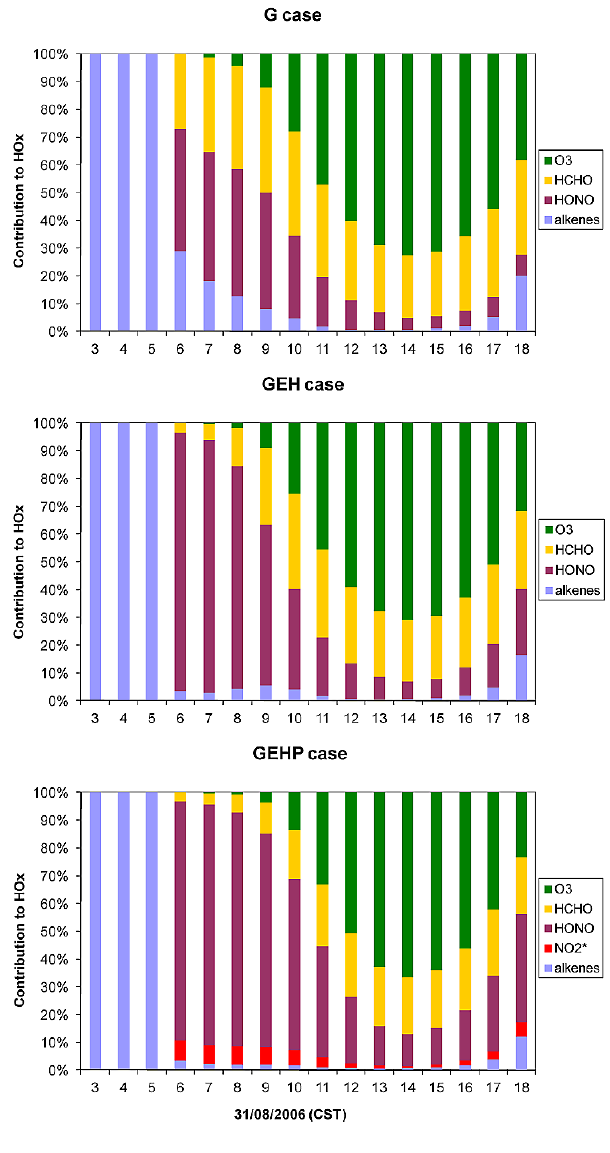
Fig. 6. Diurnal variations of contributions of O 3 , HCHO, HONO (from photolysis reaction), NO ∗ , and alkenes to the HO x budget for 2 the G case (top), GEH case (middle), and GEHP case (bottom) at the top of the Moody Tower, at